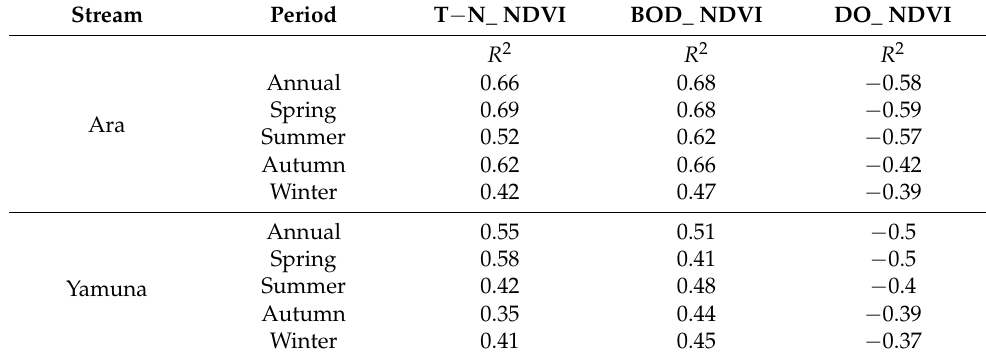
Table 4. The value of correlation coefficient among vegetation index and water quality variables. Stream Period T − N_ NDVI BOD_ NDVI DO_ NDVI R 2 0.66 Spring Ara